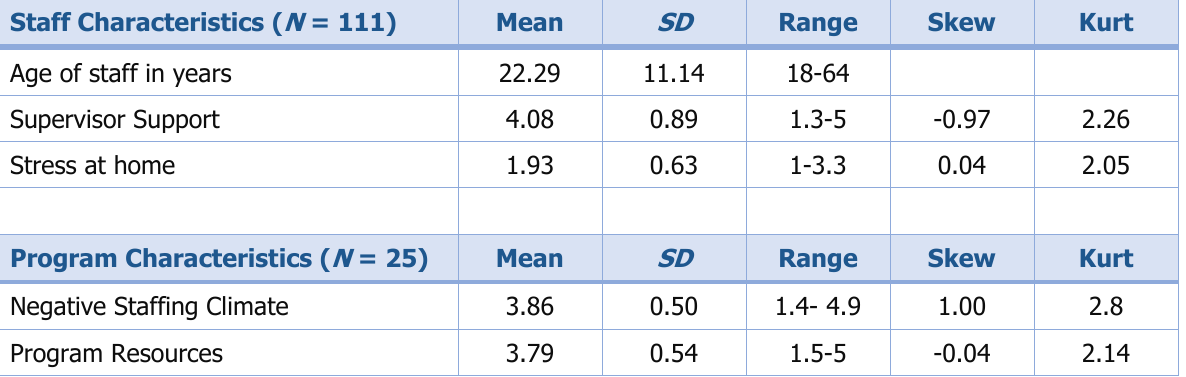
Table 2. Descriptive Statistics of Staff and Program